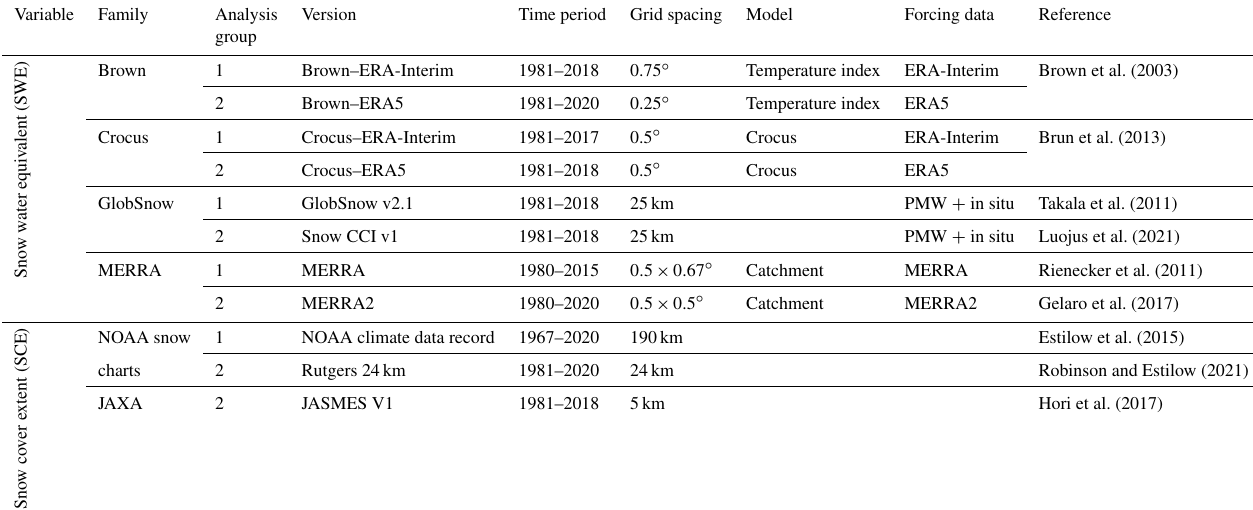
Table 1. Summary of snow datasets. Analysis group 2 represents the newest product versions relative to analysis group 1.